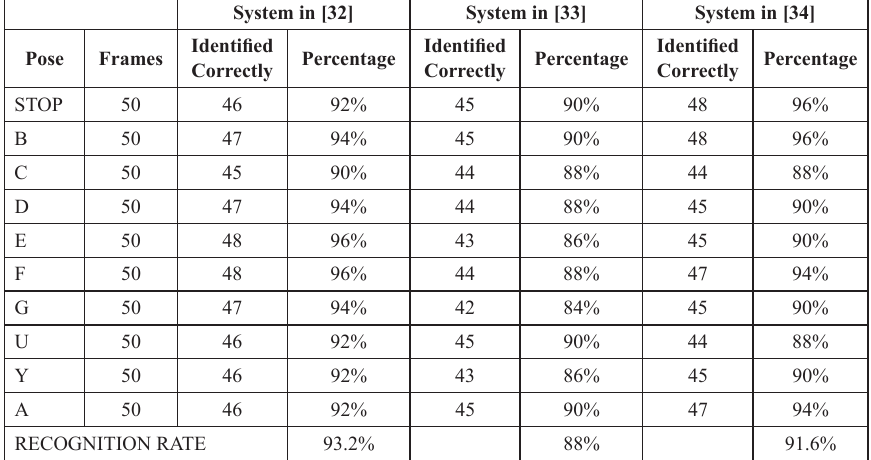
Table 1. Recognition rate of different state of the art systems